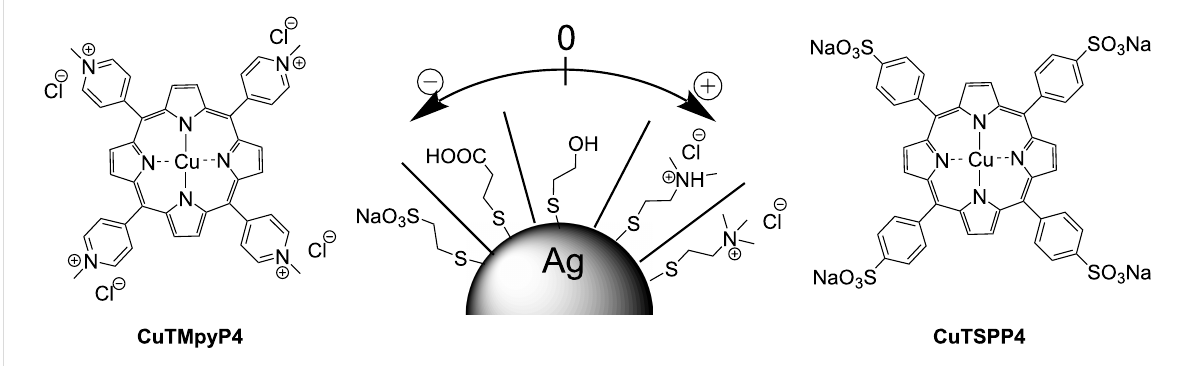
Figure 4: Schematic representation of the surface modification of immobilized Ag NPs by thiols bearing differently charged functional groups, and the oppositely charged model analytes CuTMpyP4 and CuTSPP4.